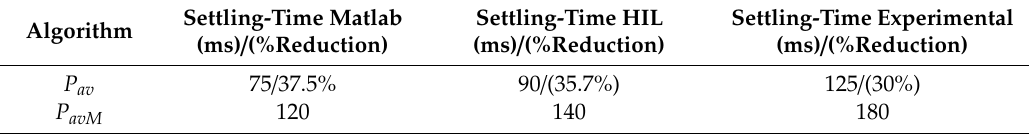
Figure 14. Experimental setup at the intelligent Microgrid Laboratory in Aalborg University, Denmark: ( a ) complete experimental setup and ( b ) detail of the Danfoss © single-phase inverter. Table 8. Simulation, HIL, and experimental results for active